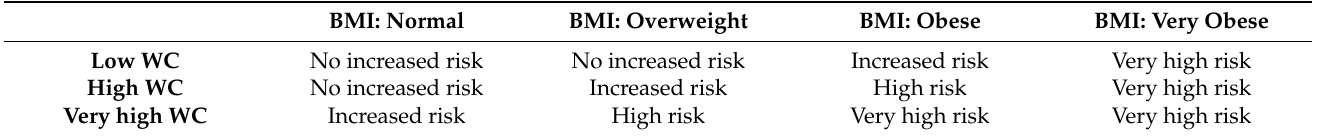
Table 1. Obesity risk groups using the NICE BMI-WC matrix